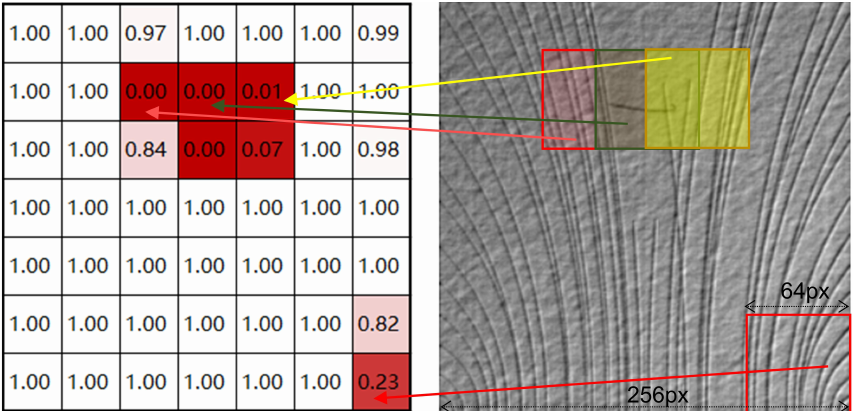
Figure 9. A defective image ( right ) and its probability matrix ( left ). The number in the box indicates the probability that the patch is non-defective.